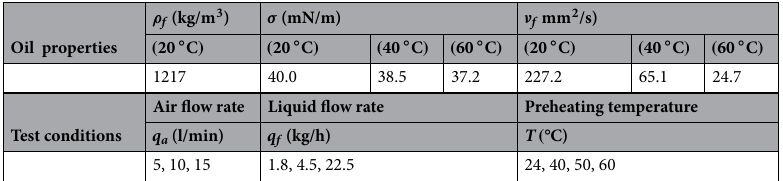
Table 1. Physical properties and test conditions. Density, surface tension 77 and kinematic viscosity are respectively denoted as ρ f , σ and ν f .